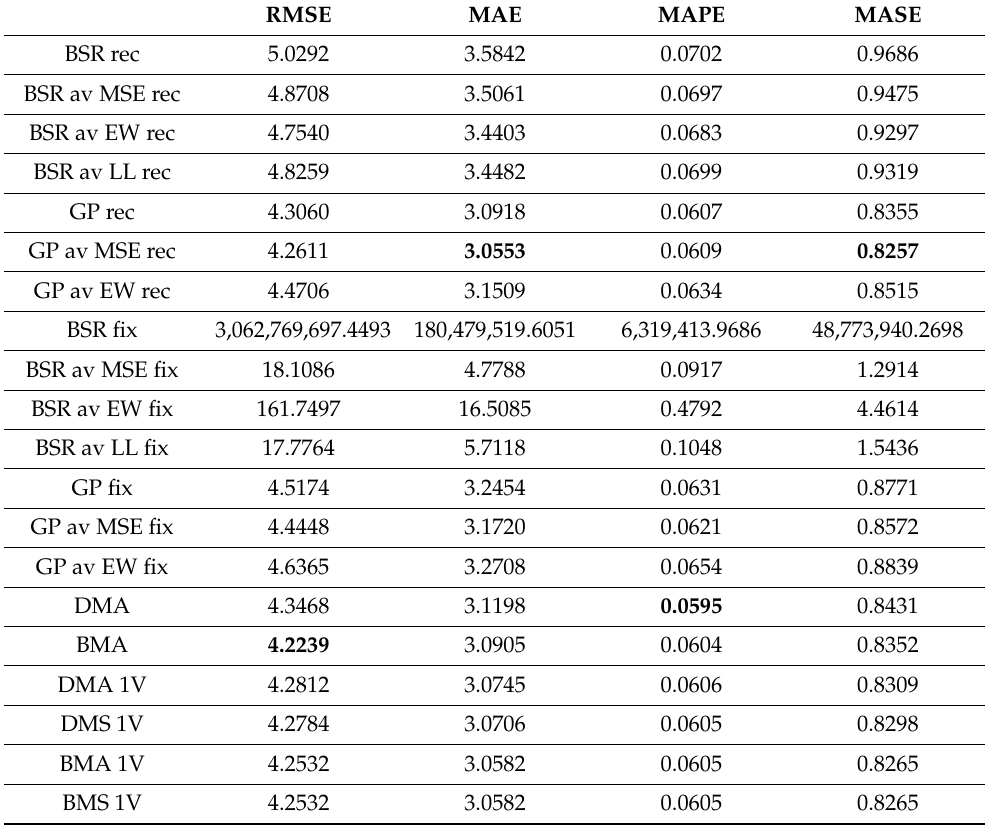
Table 5. Out-of-sample forecast accuracy for all estimated